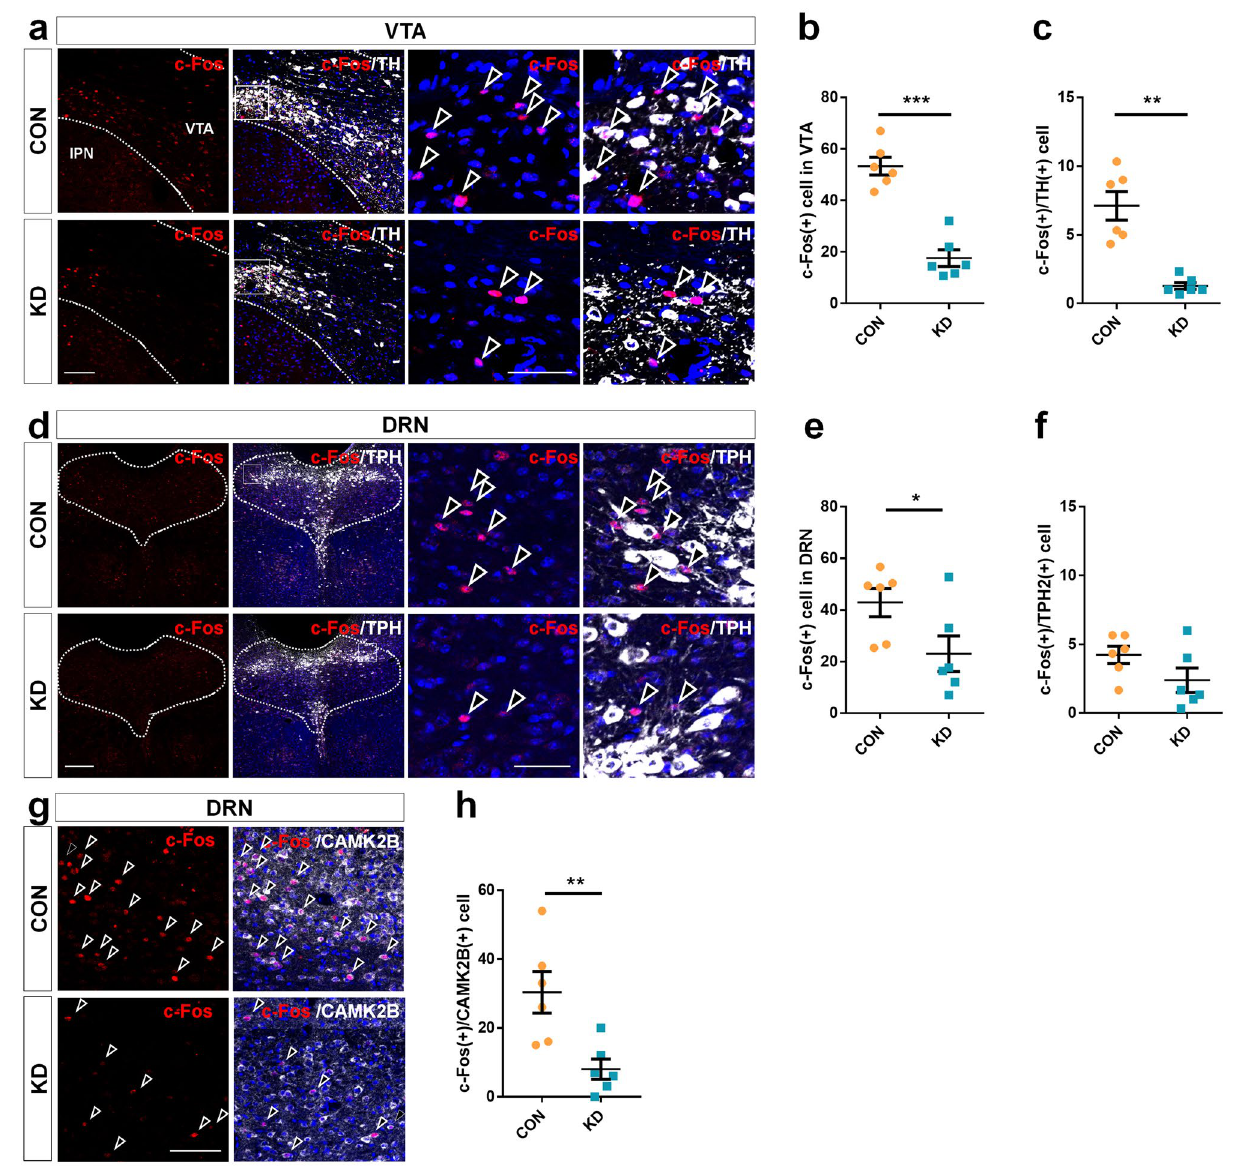
Figure 5. CAPS2 knockdown in the MHb induces altered neuronal activity in the VTA and the DRN. ( a ) Photomicrographs of VTA immunohistochemistry slices from mice injected with AAV-sh-vehicle (CON) or AAV-sh-CAPS2 (KD). MHb CAPS2 knockdown reduced c-Fos positive cells (red) in the VTA neurons. ( b and c ) C-Fos-positive cell counts and c-Fos/TH double-positive cell counts in VTA. ( d ) DRN slices from mice injected with AAV-sh-vehicle (CON) or AAV-sh-CAPS2 (KD) were used for immunohistochemistry. ( e and f ) c-Fos-positive cell count in DRN was reduced in the knockdown group, but c-Fos/TPH double-positive cell count showed no significant difference. ( g and h ) C-Fos/CAMK2B double-positive cells were reduced in DRN of the knockdown mouse. Data represent mean ± SEM, * P < 0.05, ** P < 0.01, *** P < 0.001 (CON, n = 6; KD, n = 6 mice; b , Student’s t -test, P < 0.001, c , Mann–Whitney U -test, P = 0.002; Scale bars, 200 μm; 50 μm in the magnified image, 3 sections per mouse is averaged. e and f, Student’s t -test, c-Fos: P = 0.049, c-Fos/TPH: P = 0.121 each; Scale bars, 200 μm; 50 μm in the magnified image, h , Student’s t -test, P = 0.007; Scale bars, 50